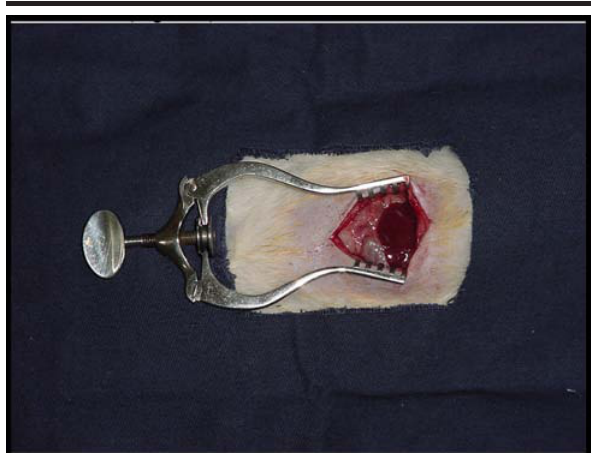
FIGURE 2 - Picture of the open cavity